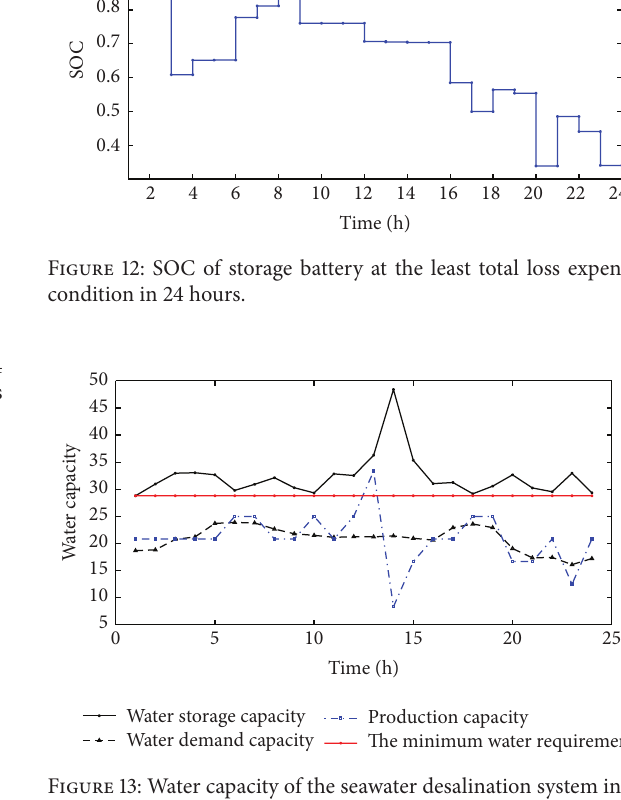
Figure 13: Water capacity of the seawater desalination system in 24